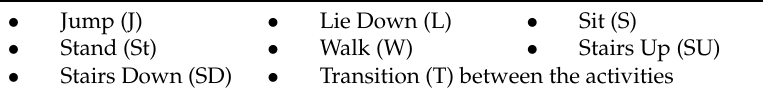
Table 2. Activities performed by users in the w-HAR